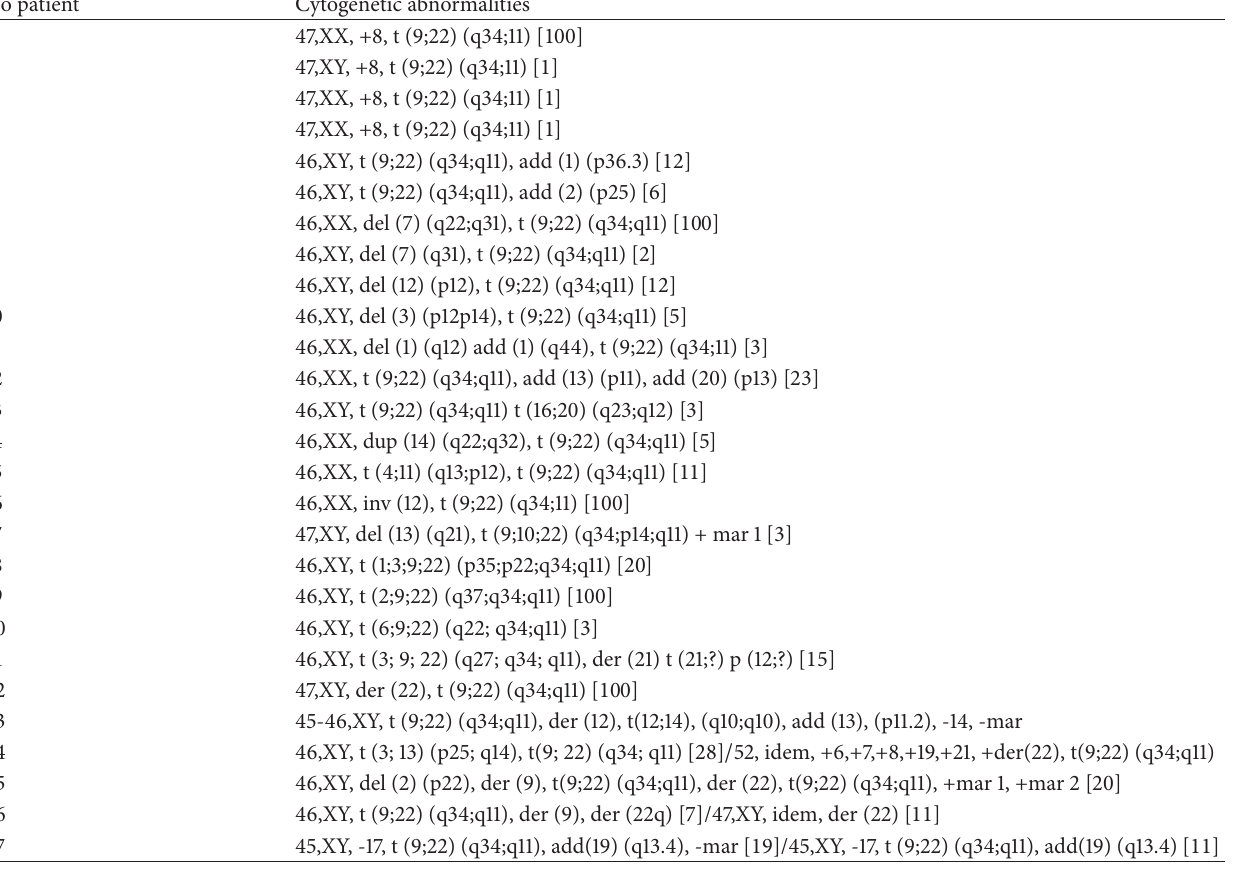
Table 2: List of additional cytogenetic anomalies at diagnosis of the 27 patients in the study. No patient Cytogenetic